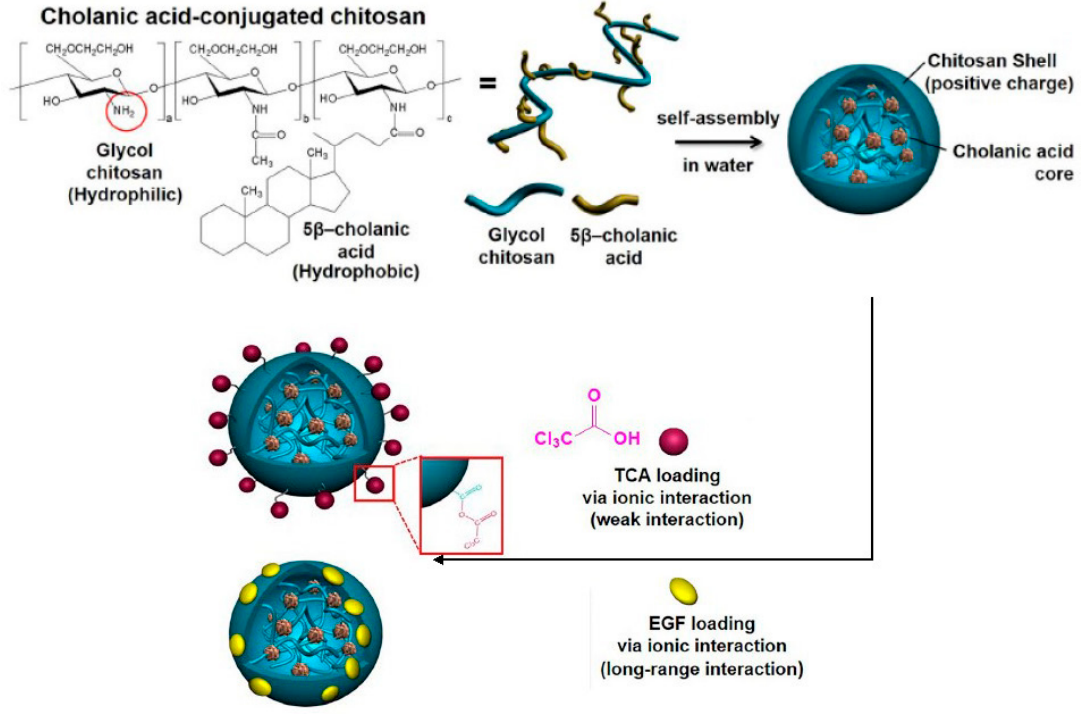
Figure 2. Preparation of HGC-based nano-controlled release system. CS was conjugated with hydrophobic cholanic acid. Hydrophobic cholanic acid is located inside the nanoparticles in water, and the hydrophilic cationic polymer amine group (NH 2 ) of CS forms the structure of the nanoparticles. Cationic CS loads anions, TCA, and EGF through ionic bonds. Reprinted with permission from ref. [17]. Copyright 2021 Springer Nature.